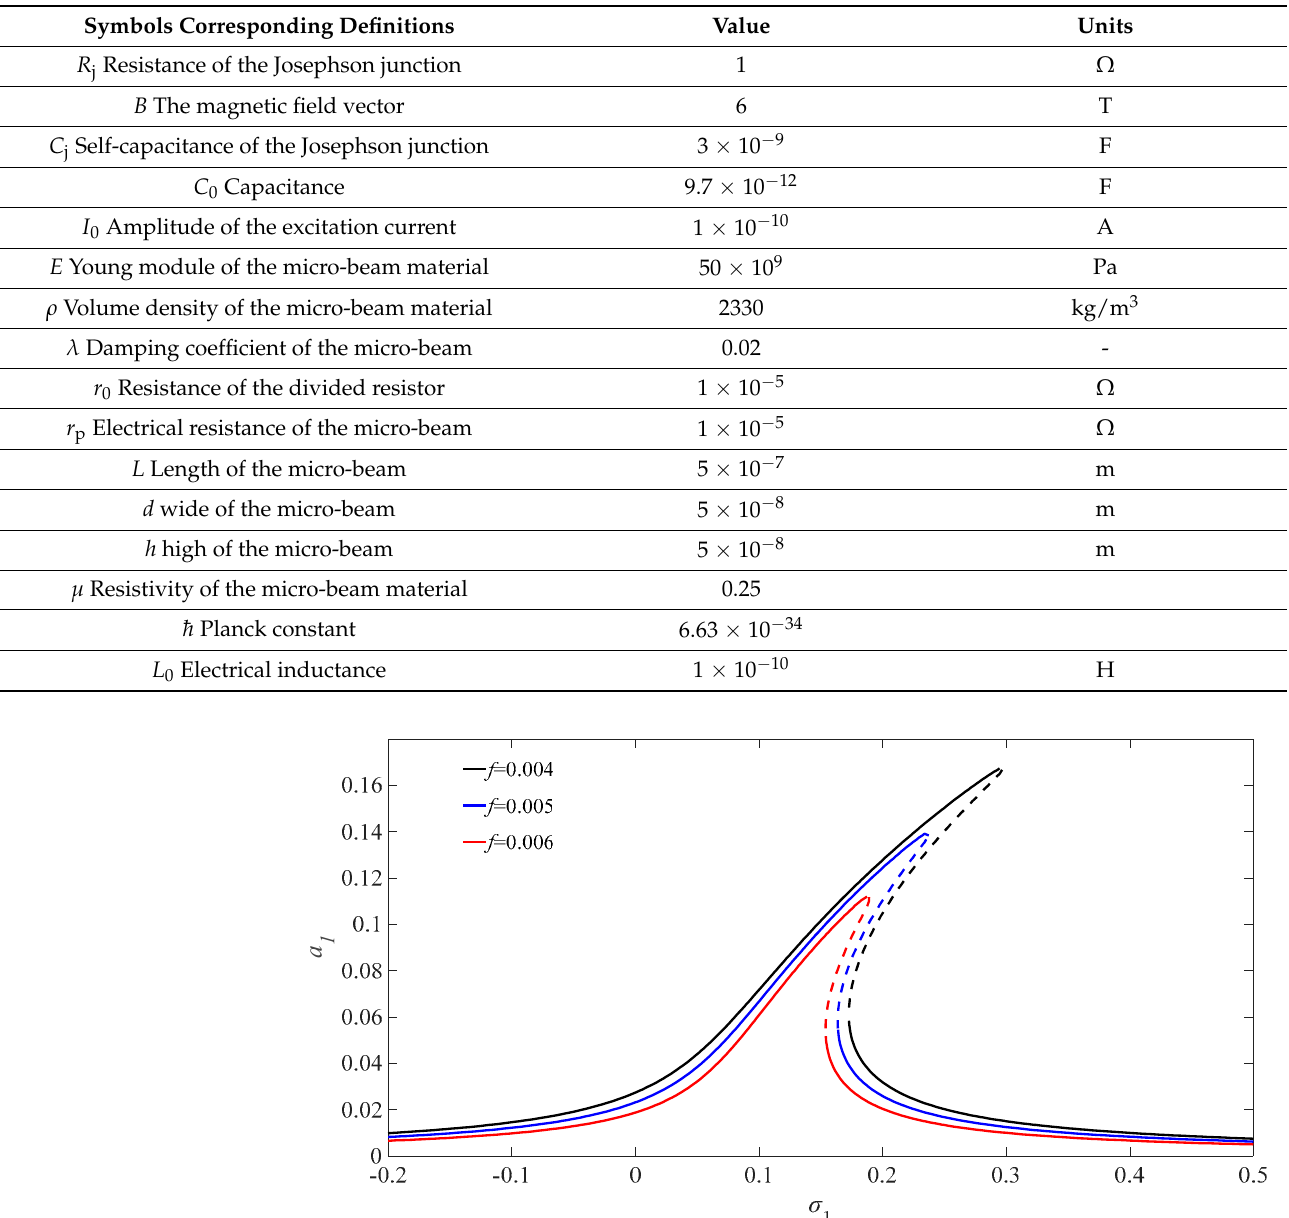
Table 1. List of symbols and corresponding definitions.